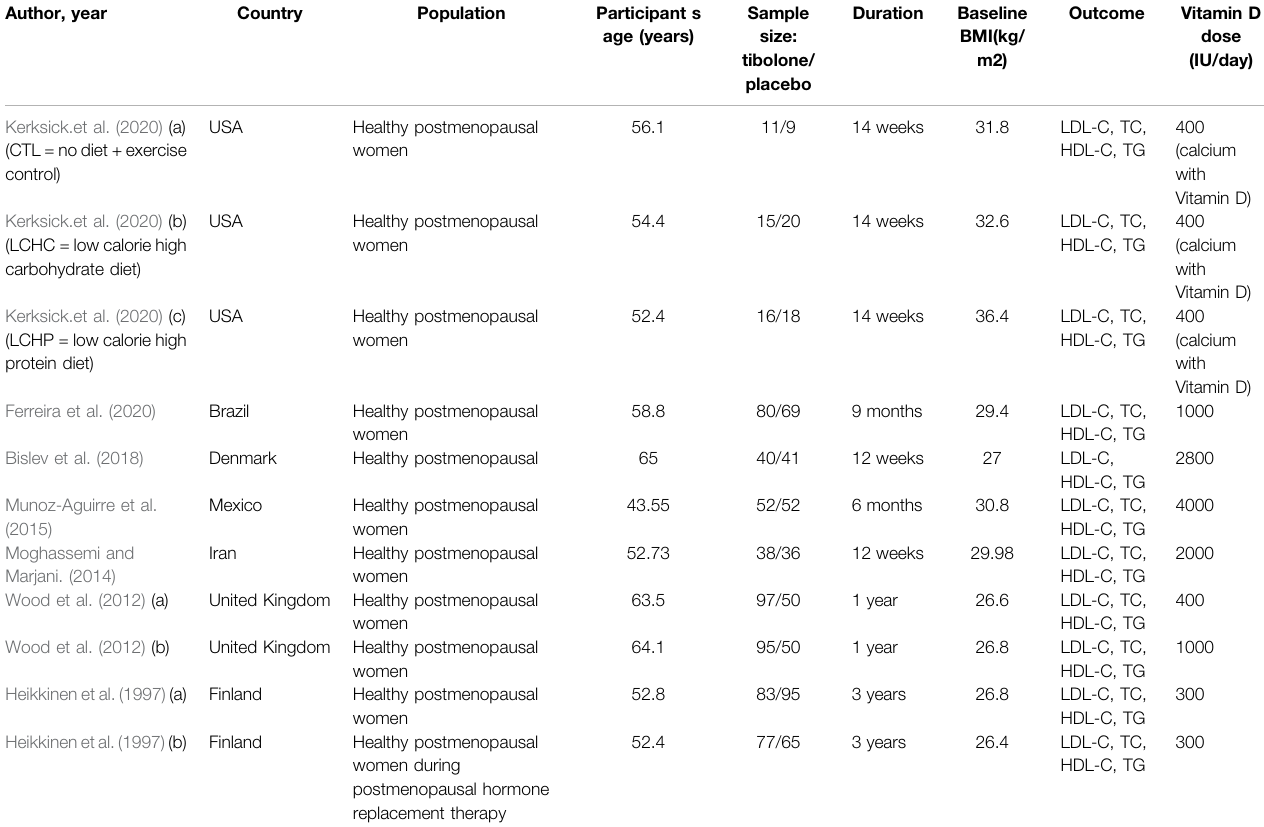
TABLE 1 | Characteristics of the eligible